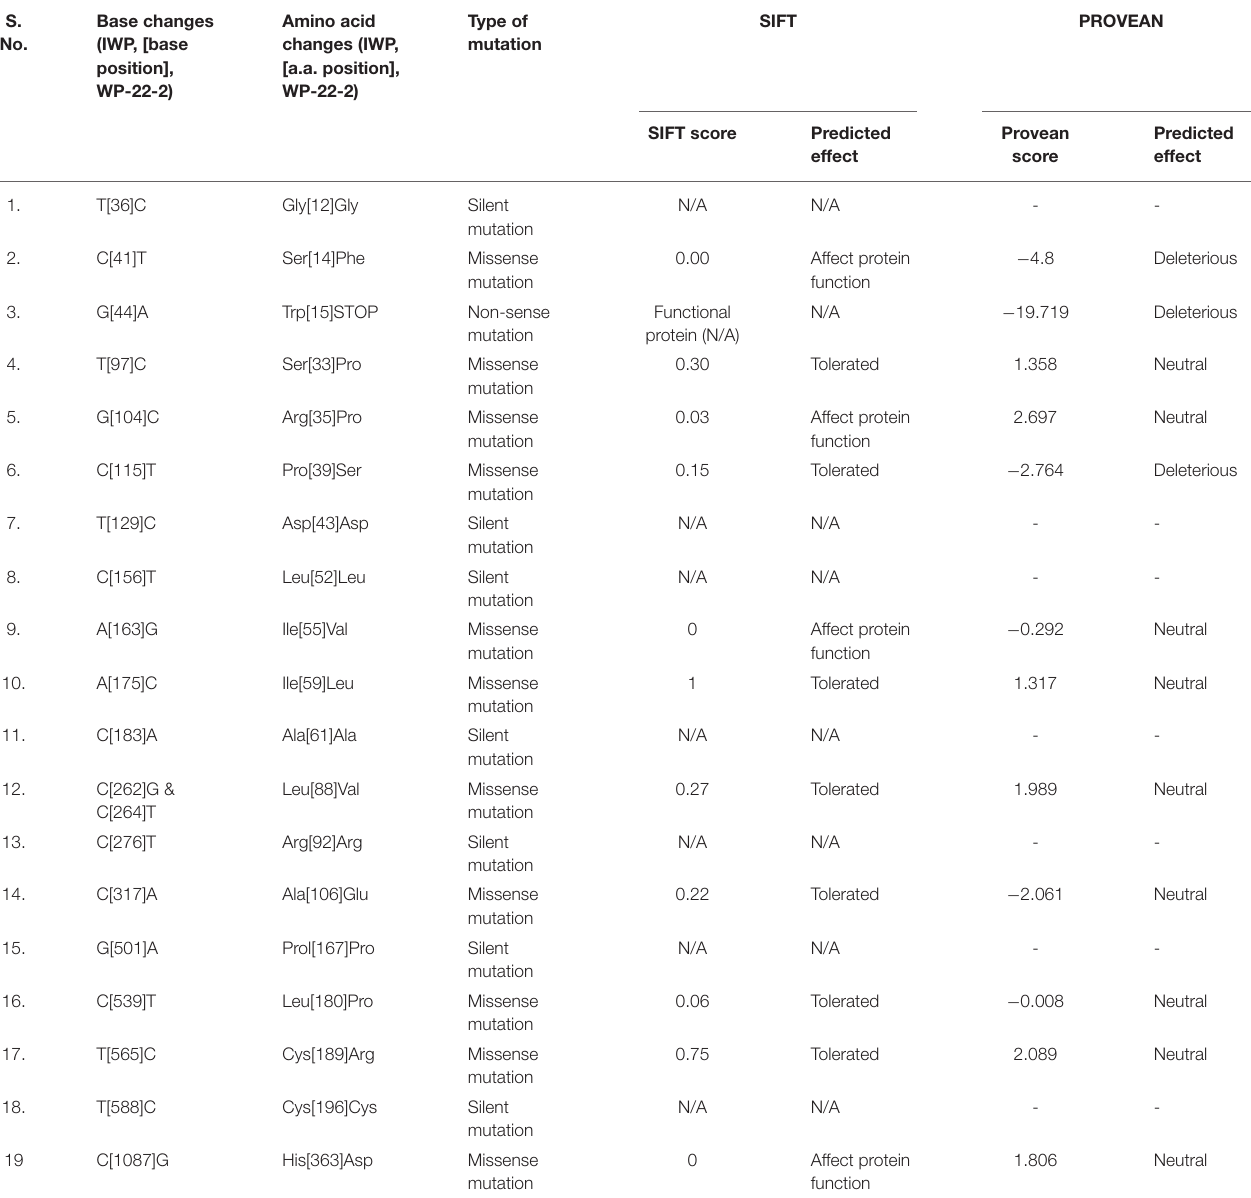
TABLE 4 | Sorting Intolerant From Tolerant (SIFT) and PROVEAN scores for mutations in the OsFBX267 gene of WP-22-2 and its predicted effects on the protein. S.